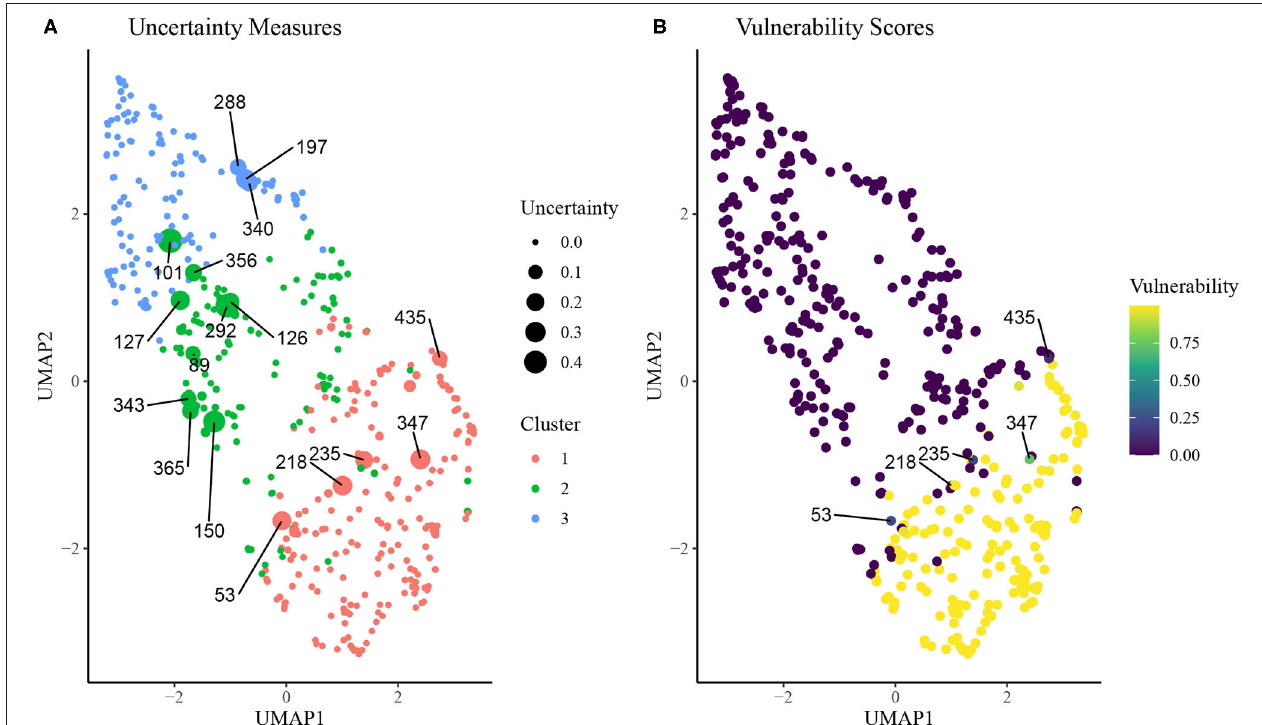
FIGURE 5 | (A) Uncertainty scores of cluster assignment for each rat on UMAP space. Animal IDs are given for subjects with uncertainty measure above 0.10, which is indicative of at least 10% of MCMC iterations spent in a cluster other than the final inferred cluster. (B) Vulnerability scores for each rat on UMAP space. Animal IDs were shown for subjects with uncertainty above 0.10 and vunerability <